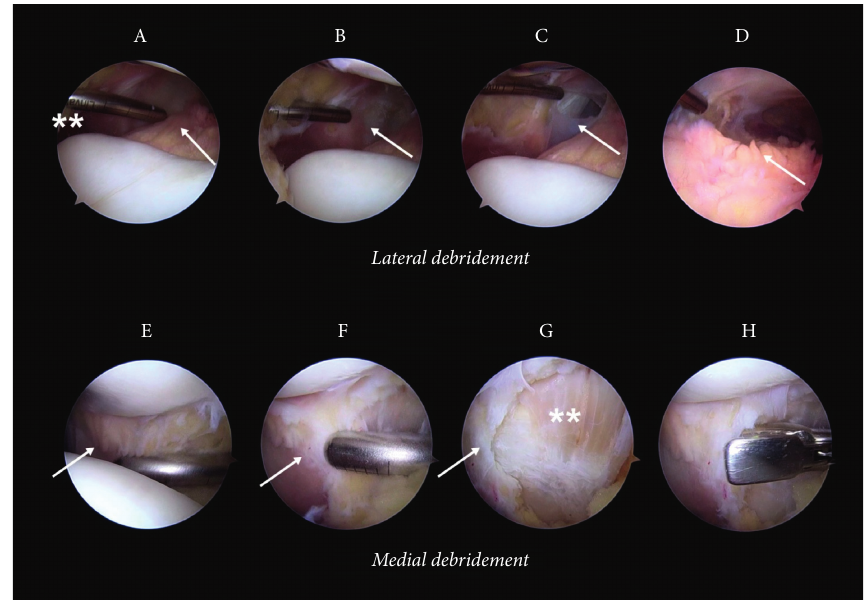
Figure 1: Concentric arthroscopic debridement of the inner reticulum. (a) A to D show a progressive sequence of the lateral debridement of the inner medial retinaculum. E to H show a progressive sequence of the medial debridement of the inner medial retinaculum. The asterisks show the lateral portal location, and the arrow shows the inner retinaculum. (b) The image shows the distal debridement, and the arrow shows the inner retinaculum. (c) The image shows the intact layer II of the retinaculum, and the arrow shows the inner layer of the retinaculum. (d) The image shows fibrin in the meniscus, and adherences are visualized at the inner layer of the retinaculum. (e) The image shows the debrided inner medial layer of the retinaculum, and the arrow shows the intact inner layer. (f) The image shows the inner medial layer of the retinaculum under debridement, and the arrow shows the intact inner layer. (g) The asterisks show the medial layer II of the retinaculum, and the arrow shows the inner layer. (h) The debridement is completed using a basket